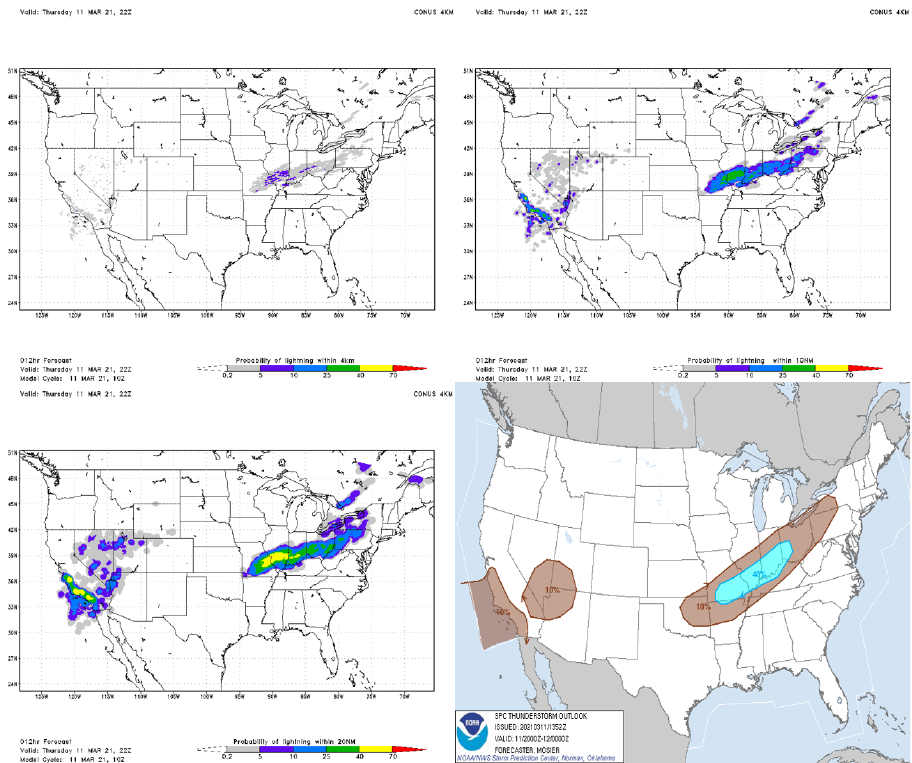
Figure 15. ( Top Left ): Probability (percent) of lightning within 4 km from the 4-km MEPS. ( Top Right ): Probability (percent) of lightning upscaled to within 10 nautical miles (18.5 km) from the 4-km MEPS. ( Bottom Left ): Probability (percent) of lightning upscaled to within 20 nautical miles (37 km) from the 4-km MEPS. All probabilities shown from an ensemble initialized 1000 UTC on 11 Mar 2021, valid from 2100 to 2200 UTC on 11 Mar. ( Bottom Right ): US Storm Prediction Center thunderstorm probability (within 12 miles or 19.3 km of a point) issued at 1352 UTC on 11 Mar 2021, valid from 2000 UTC 11 Mar to 0000 UTC 12 Mar.